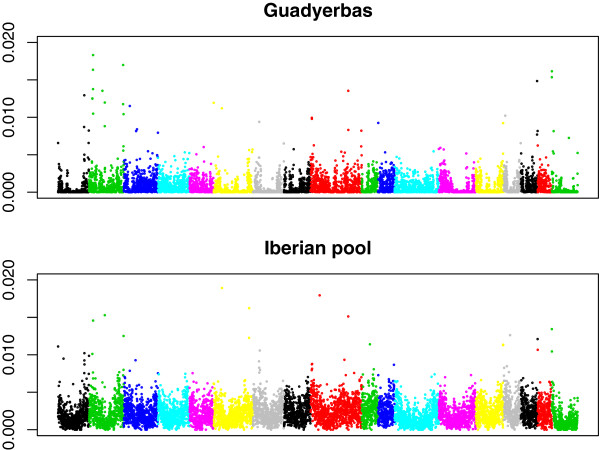
Watterson’s nucleotide variability (per bp) distribution by chromosome (SSC1-SSC18, SSCX) in the pool (top) and the individual (bottom). Each dot represents a 200 kb length window, and each chromosome, in a different color.